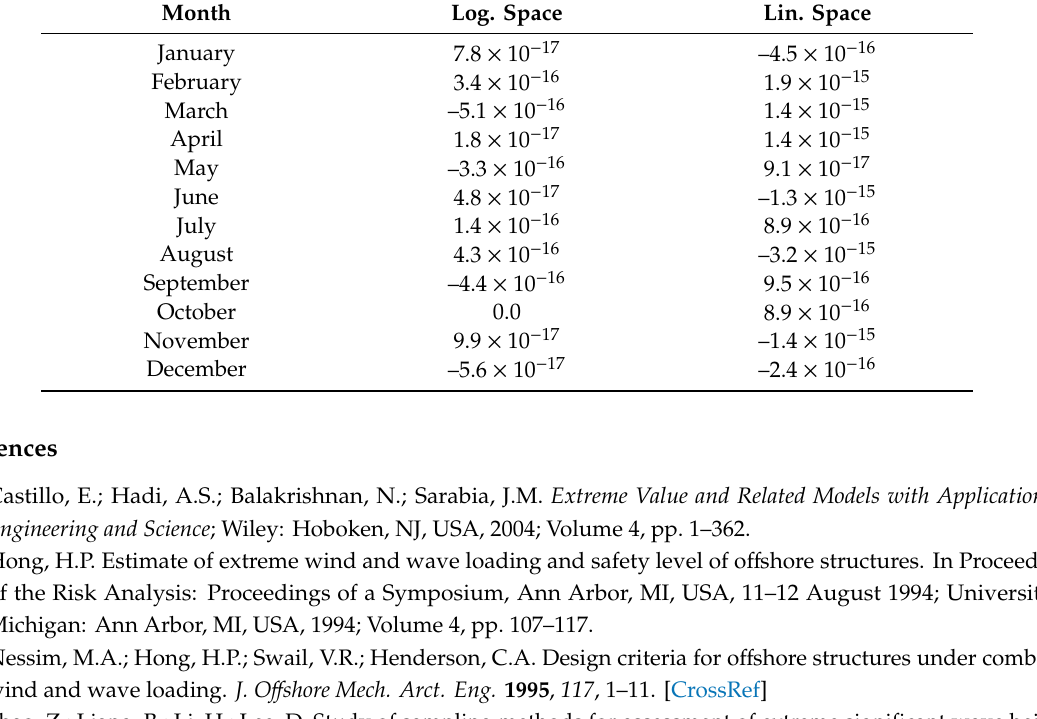
Figure A9. Regression lines and confidence intervals including (solid and dashed lines, respectively) and excluding (dashed–dotted and dotted lines, respectively) T -yr values for December; ( a ) and ( b ) for logarithmic space and linear space, respectively. Filled circles represent T -yr values with embedded perpendicular lines indicating confidence intervals from GEV models.